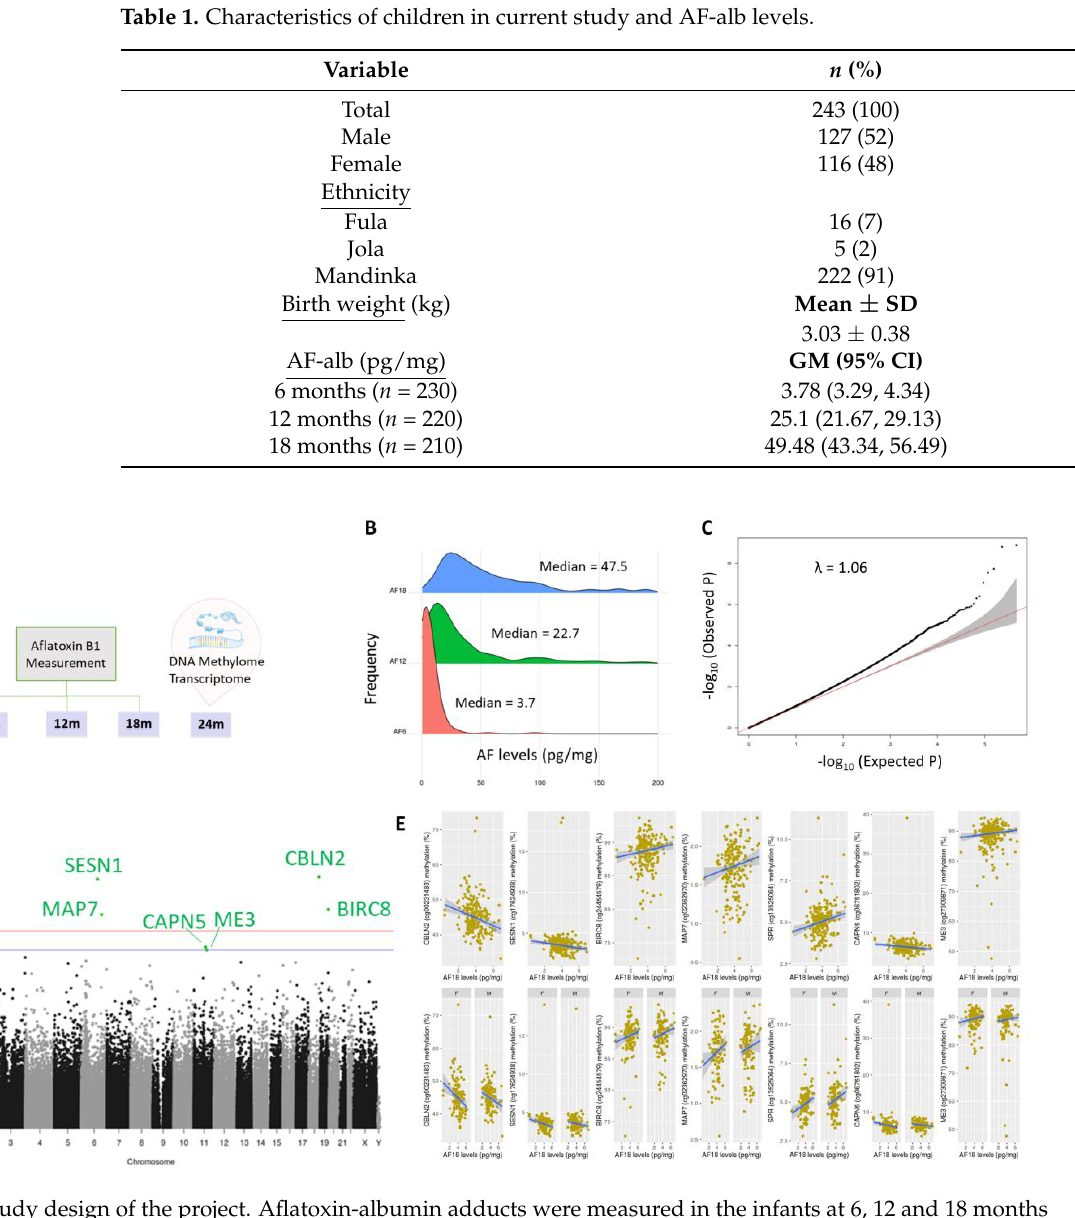
Table 1. Characteristics of children in current study and AF-alb levels.